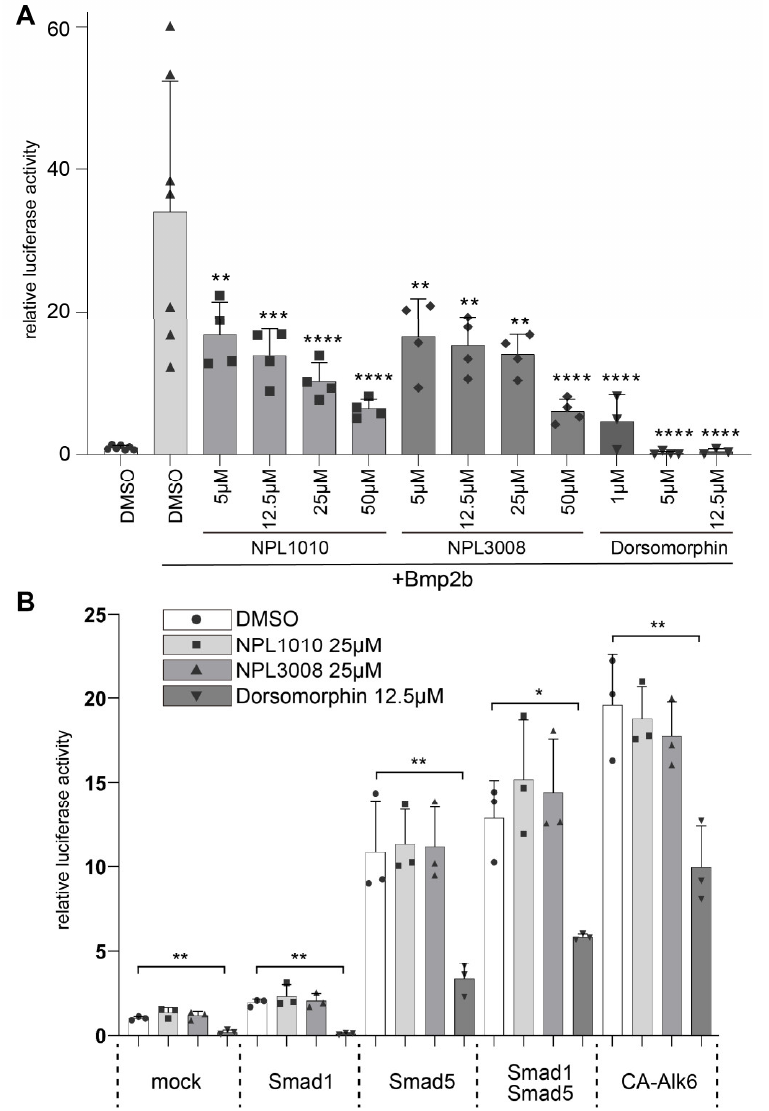
Figure 4. NPL1010 and NPL3008 decrease activity of the BMP signaling reporter. ( A ) Relative luciferase activity of the BMP signaling reporter. BRE reporter and internal control plasmids were transfected into C2C12 cells. The control or bmp2b expression vector was cotransfected, and cells were treated with the indicated concentrations of NPL1010, NPL 3008, or dorsomorphin. The